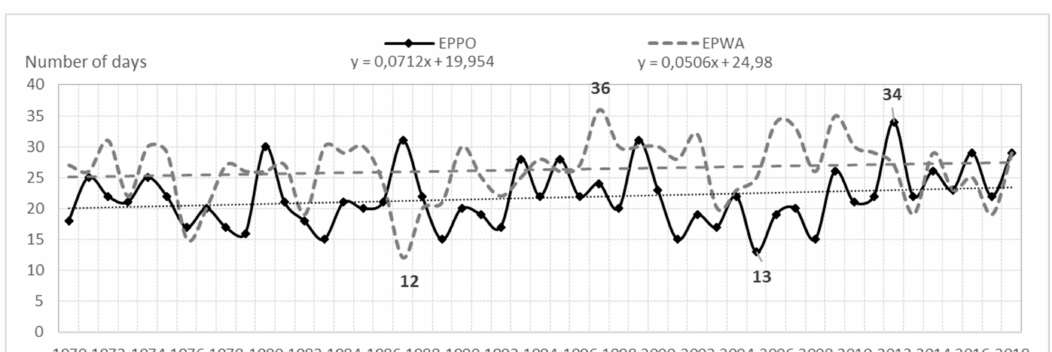
Figure 1. Average annual number of storm days and a linear trend in EPGD and EPSC (1970–2018).